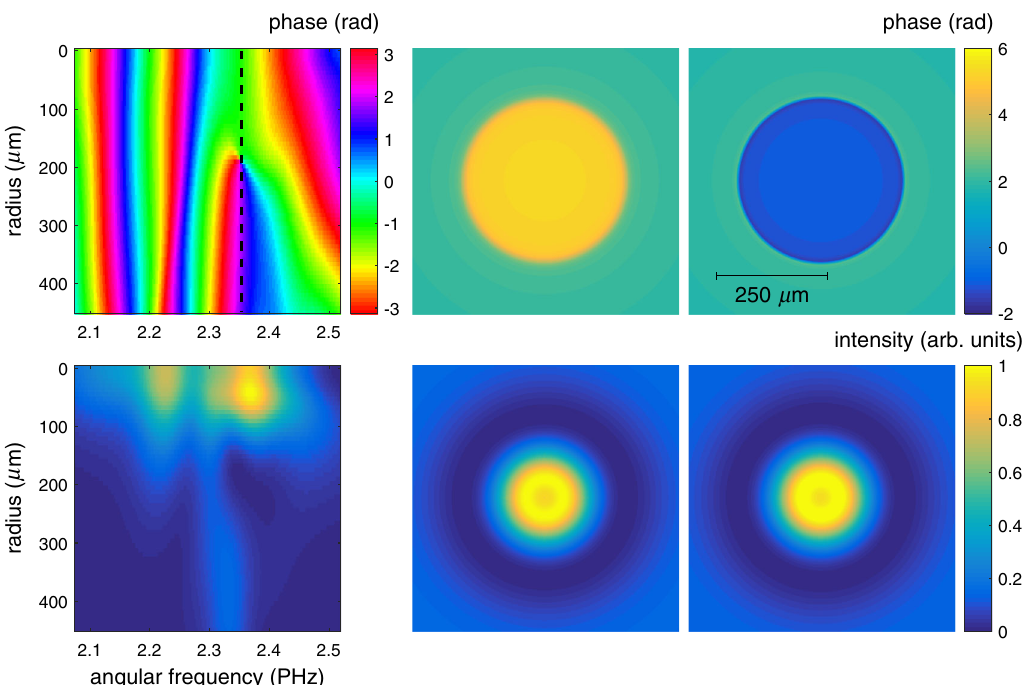
FIG. 9. Spectral phase (radians, top) and spectral intensity (arbitrary units, bottom) taken from simulation at z ¼ 180 cm as the vortex core in the spatiospectral domain crosses 2.35 PHz ( λ ¼ 800 nm). Simulation parameters are the same as Fig. 3 of the main text: 6 . 4 ), pulse FWHM 45 fs. From left to right, the top row (bottom row) shows the full w 0 ¼ 1 . 3 mm, pulse energy 2.8 mJ ( P=P cr ¼ spatial-spectral phase (intensity), as well as spatial phase (intensity) slices spectrally fore and aft of 800 nm. The dashed black line in the top left-hand panel intersects the vortex